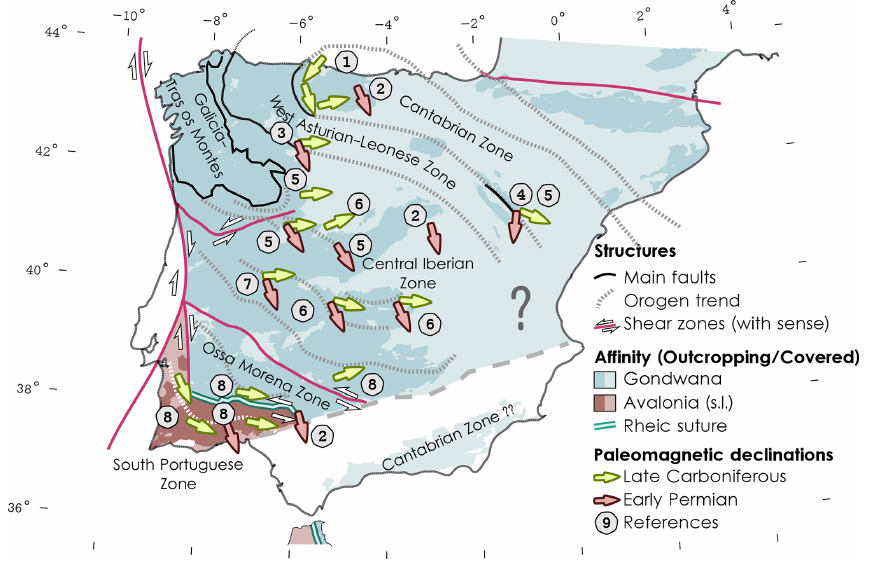
Figure 6. Paleomagnetic studies related to the Cantabrian Orocline and the Central Iberian curve: (1) synthesis of paleomagnetism in the core of the Cantabrian Orocline (see Weil et al., 2013); (2) Permian (eP) components synthesized in Weil et al. (2010b); (3) Ordovician volcanics and limestones (Laquiana) in the boundary between the West Asturian–Leonese and Central Iberian zones (Fernández-Lozano et al., 2016); (4) Devonian sedimentary sequences and Permian subvolcanics in the Iberian ranges (Pastor-Galán et al., 2018); (5) Permian dikes and sills (Calvín et al, 2014); (5) Anatectic granites (E1) and mantle-derived granitoids (C3) from Tormes dome and Central System (Pastor- Galán et al., 2016); (6) Cambrian limestones from Tamames (N) and los Navalucillos (S) (Pastor-Galán et al., 2015a); (7) Ediacaran–early Cambrian sedimentary rocks in the southern sector of the Central Iberian Zone (Pastor-Galán et al., 2017b); (8) Almadén volcanics from the Central Iberian Zone (Perroud et al., 1991; Parés and van der Voo, 1992; Leite Mendes et al., 2020) and Volcanic rocks from the southern Ossa-Morena and the South Portuguese zones (Leite Mendes et al.,